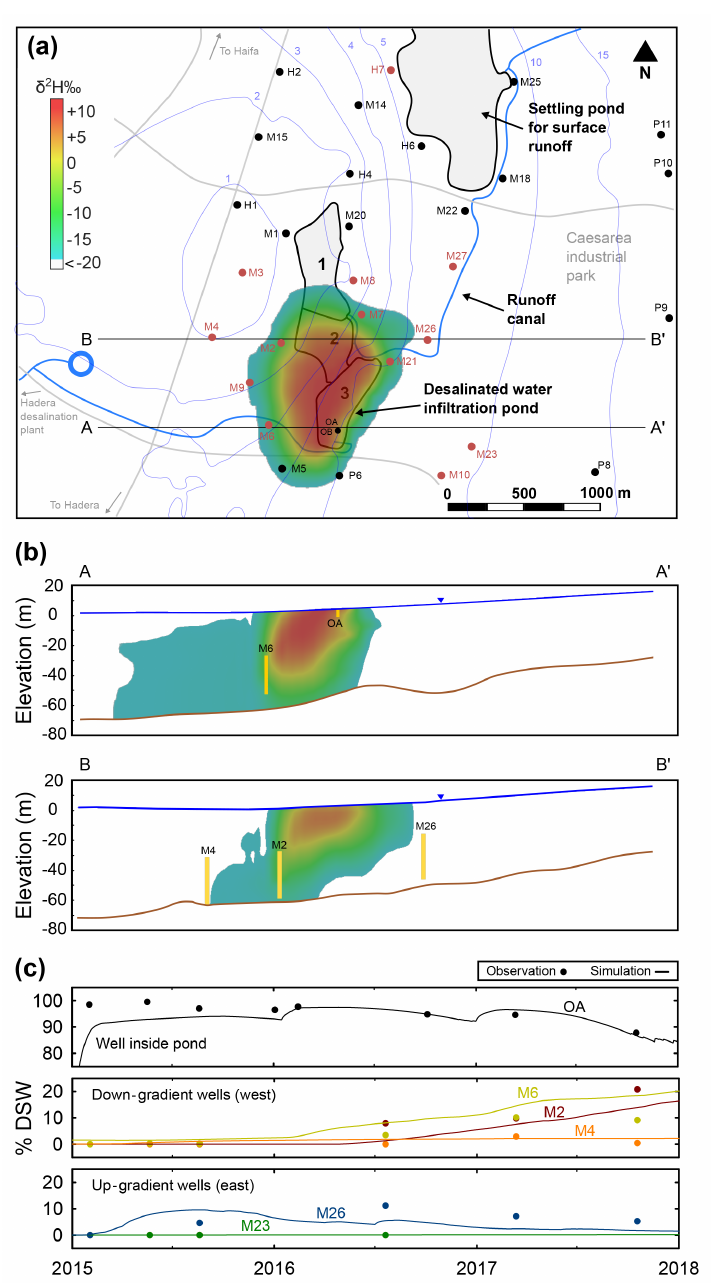
Figure 5. Simulation results showing DSW spreading at the end of 2017. (a) Plan view (water table); the colored area shows the DSW plume, the white area indicates natural GW ( δ 2 H< − 20‰) and the blue contours are the GW head. (b) East–west cross sections through wells OA and M6 (A-A (cid:48) ) and wells M4, M2 and M26 (B-B (cid:48) ); well screens are shown in yellow. (c) Observed and simulated DSW fraction (%) in selected wells along the cross sections A-A (cid:48) and B-B (cid:48) .